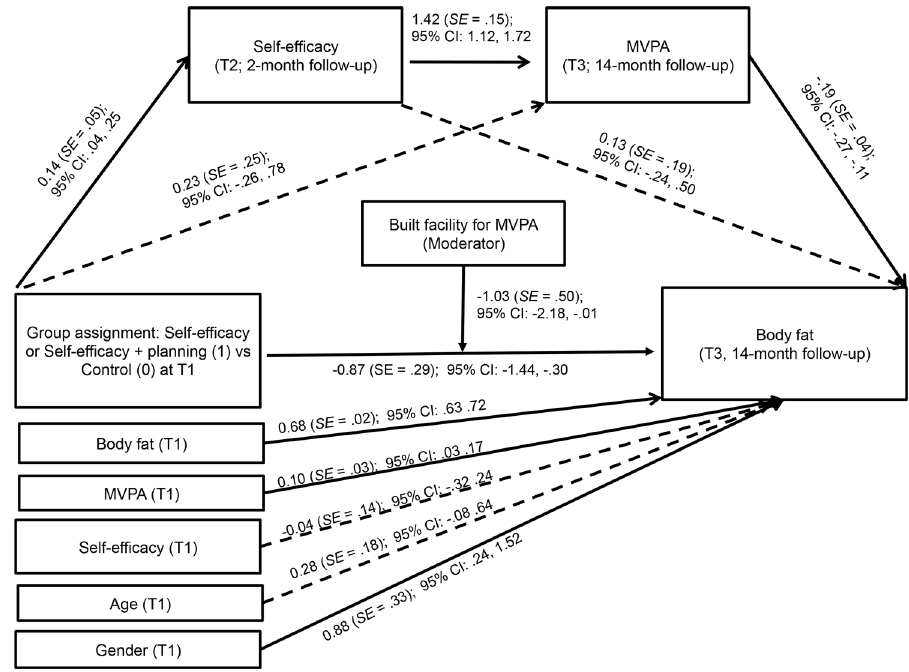
Fig 2. Effects of the group assignment (self-efficacy or self-efficacy + planning versus control) on body fat (14-month follow-up) mediated by self-efficacy and moderate-to-vigorous physical activity. Solid lines represent significant associations. MVPA – moderate-to-vigorous physical